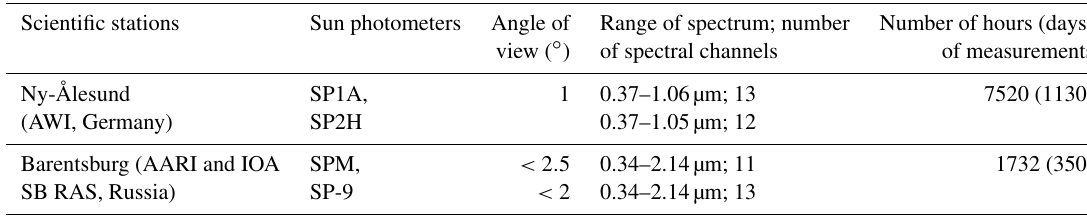
Table 1. Characteristics of the sun photometers and the data volume in Ny-Ålesund and Barentsburg. Scientific